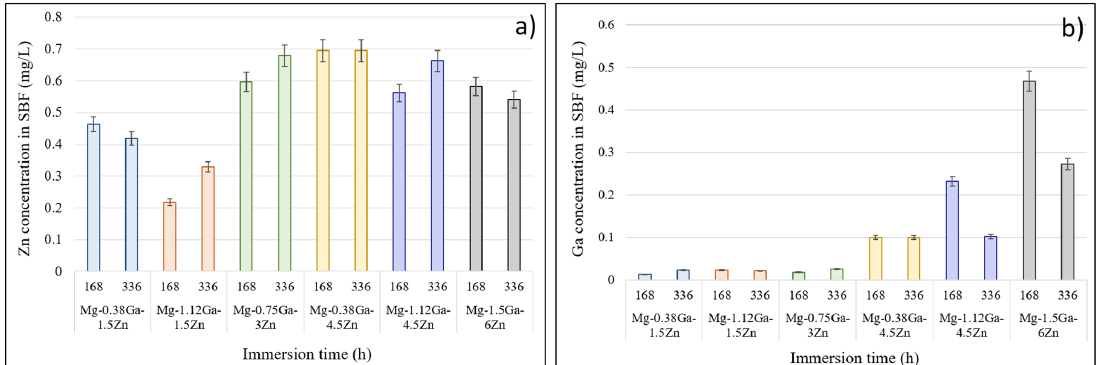
Figure 10. Ionic concentration of remaining SBFs, ( a ) Zn and ( b ) Ga after 168 and 336 h of immersion of the alloys.